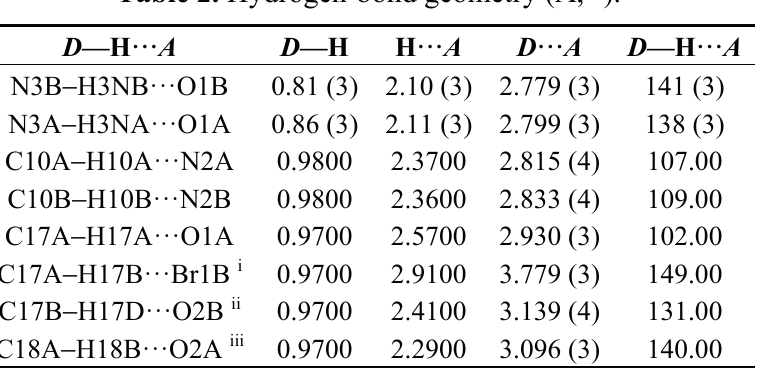
Figure 4. Crystal packing showing intermolecular hydrogen bonds as dashed lines. Table 2. Hydrogen-bond geometry (Å,